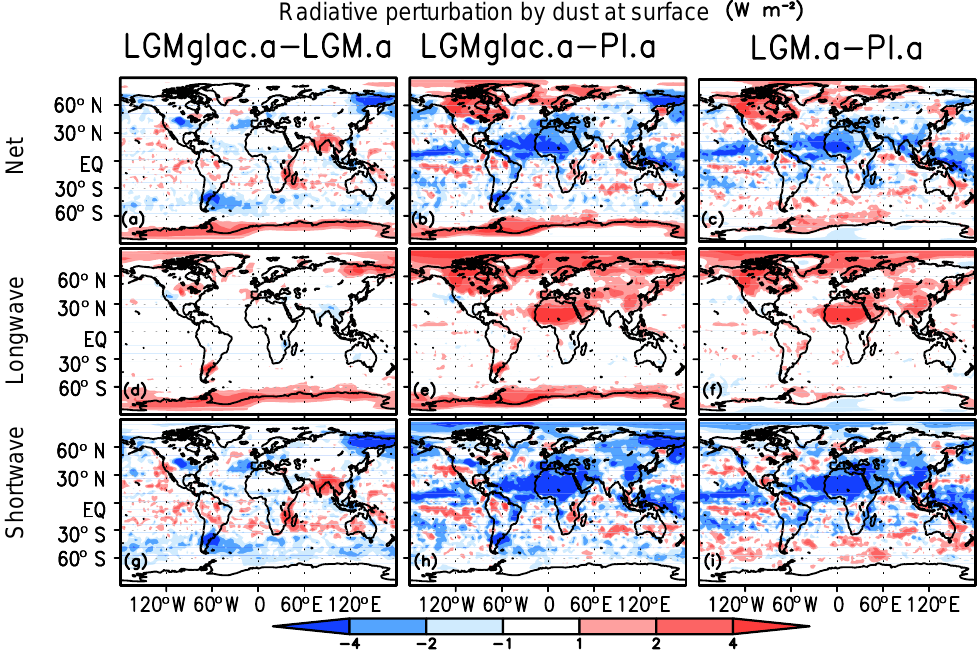
Figure 10. Change in net radiative perturbation by dust at the surface: (a) LGMglac.a–LGM.a, (b) LGMglac.a–PI.a, and (c) LGM.a–PI.a. Decomposition of net change for longwave radiation: (d) LGMglac.a–LGM.a, (e) LGMglac.a–PI.a, and (f) LGM.a–PI.a; for shortwave radiation: (g) LGMglac.a–LGM.a, (h) LGMglac.a–PI.a, and (i)